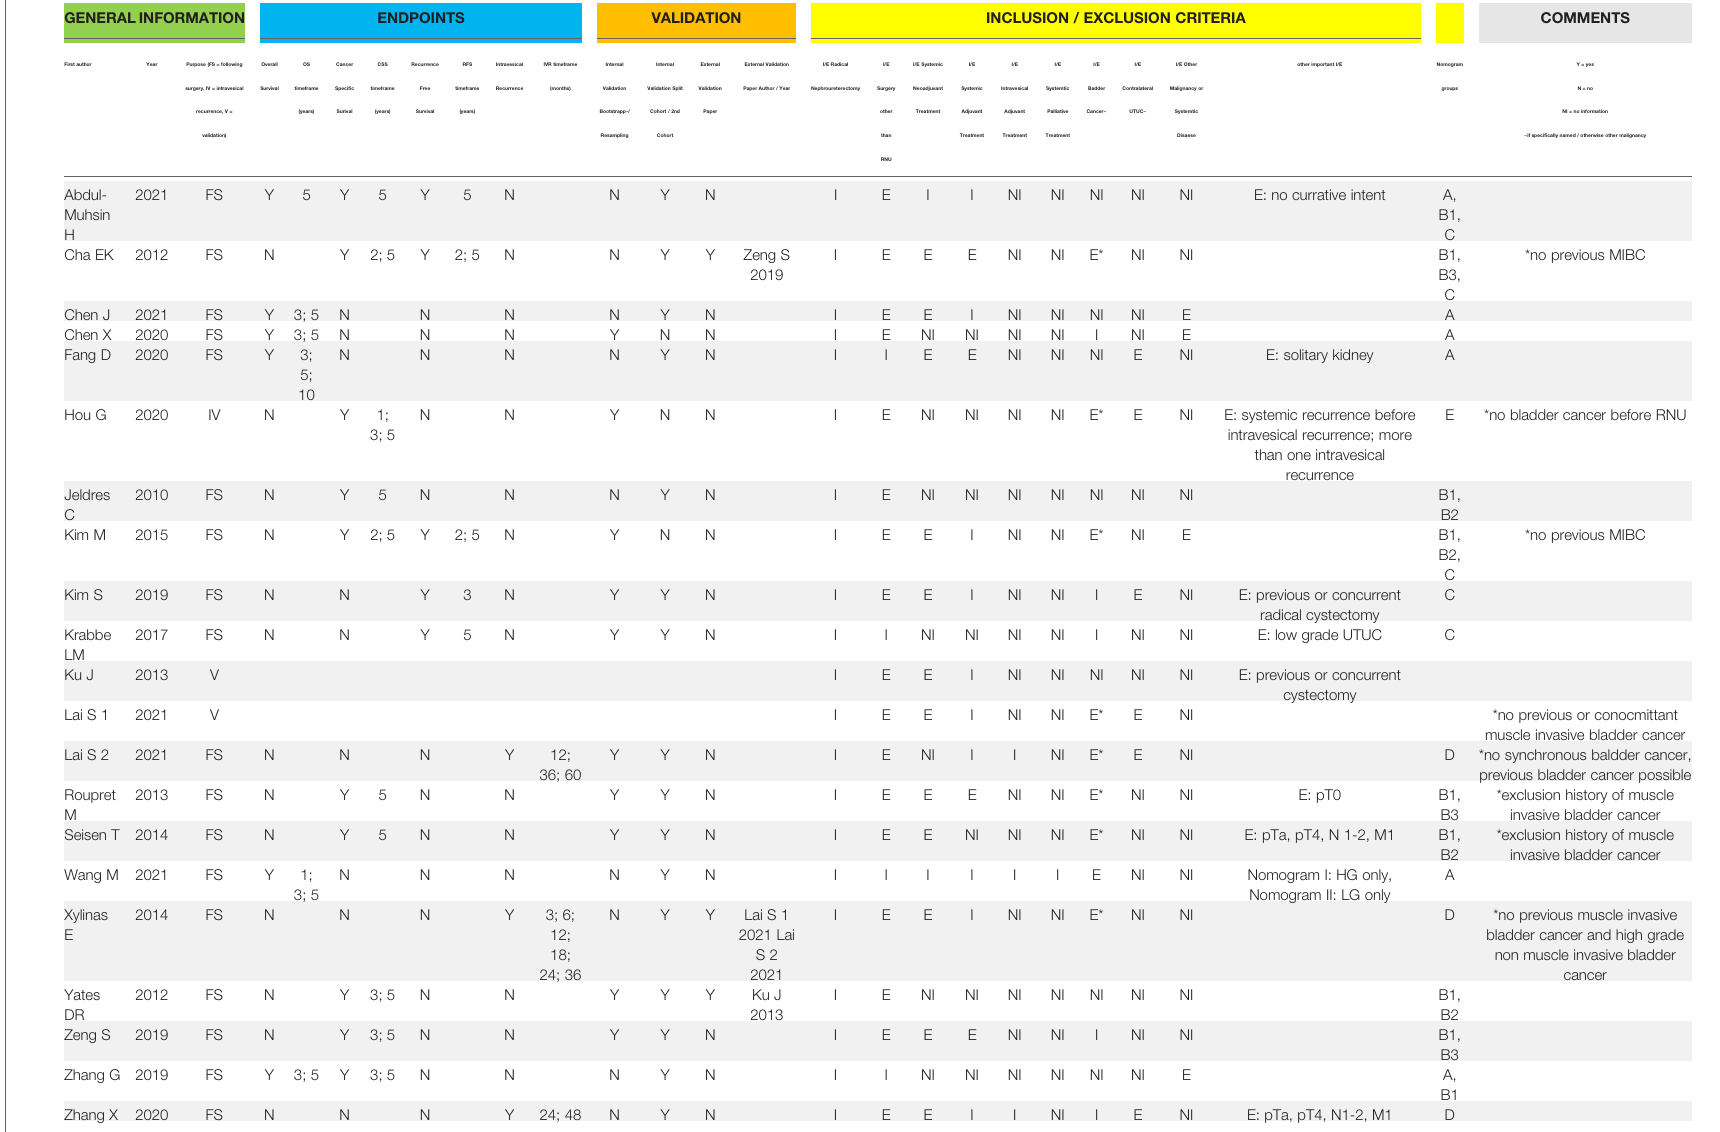
TABLE 1 | This table summarizes the publications included in the systematic review, highlighting nomogram prediction outcome, nomogram validation, and patient inclusion and exclusion criteria.